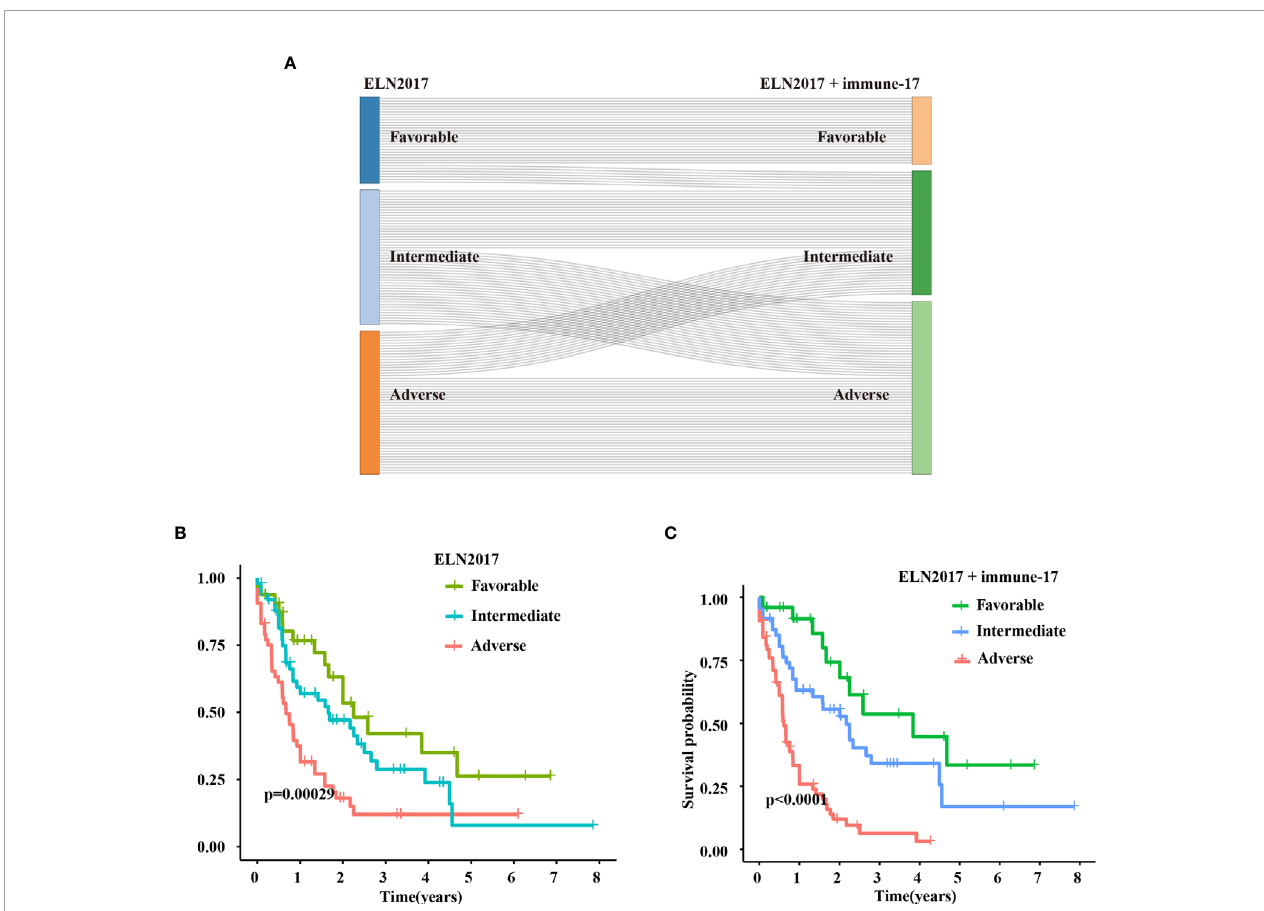
FIGURE 3 | Improved ELN2017 risk strati fi cation system. (A) Re-strati fi cation of patients from the three ELN2017 categories to the novel three ELN2017+immune- 17 categories. Each line represents a patient. The line ’ s left end means the ELN2017 categories and the line ’ s right end means novel ELN-immune-17 categories. If the line is parallel, the patient ’ s classi fi cation is not change. If not, the patient ’ s classi fi cation has changed. Kaplan – Meier analysis for AML patients strati fi ed by ELN2017 risk strati fi cation system (B) or ELN2017+immune-17 risk strati fi cation system (C)